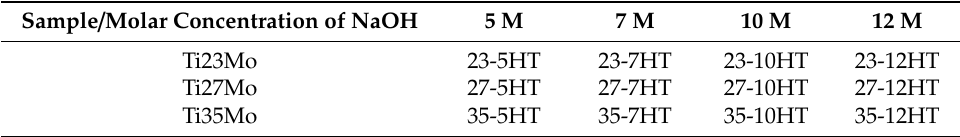
Table 2. Sample indication after hydrothermal